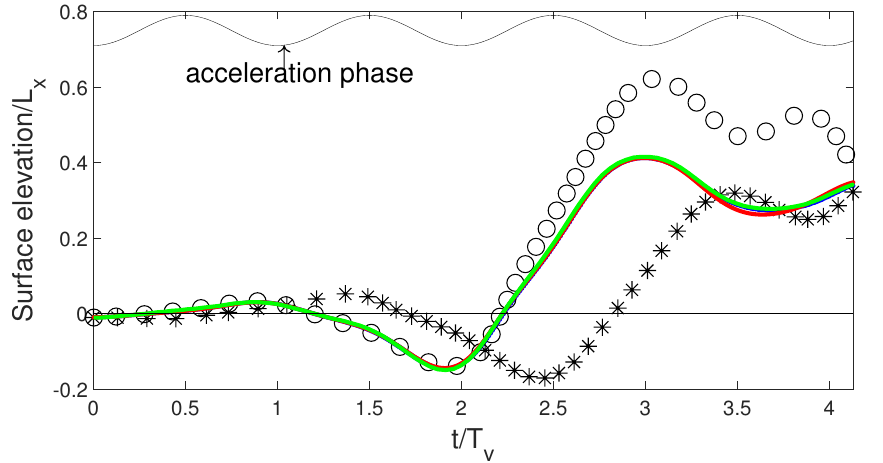
Figure 3. Comparison of different approaches in the nonlinear regime: surface elevation at the midpoint. (o) Wright et al. [7], (*) PF S [15], (–) EbFVM S (this work), (–) FT S (this work), (–) VOF S (this